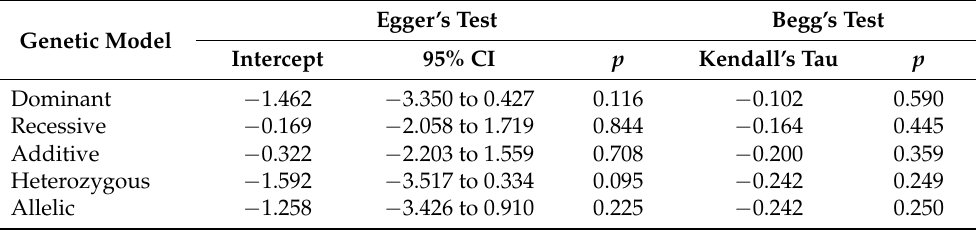
Table 4. The results of Egger’s and Begg’s tests for all genetic models between the studies analysing MI patients and